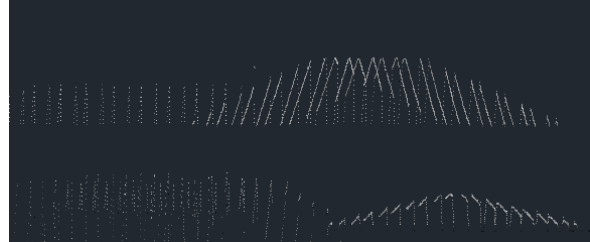
Figure 3. This figure shows the profile of the buildings that shown in Figure 2. This figure shows how the curvature at edges of roof is changing